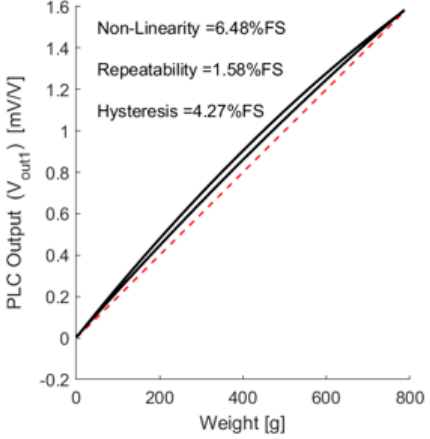
Figure 11. Loading/unloading test of the PLC to the rated load, 0.8 kg: ( a ) 5 time measurements; and ( b ) hysteresis char- acteristic.